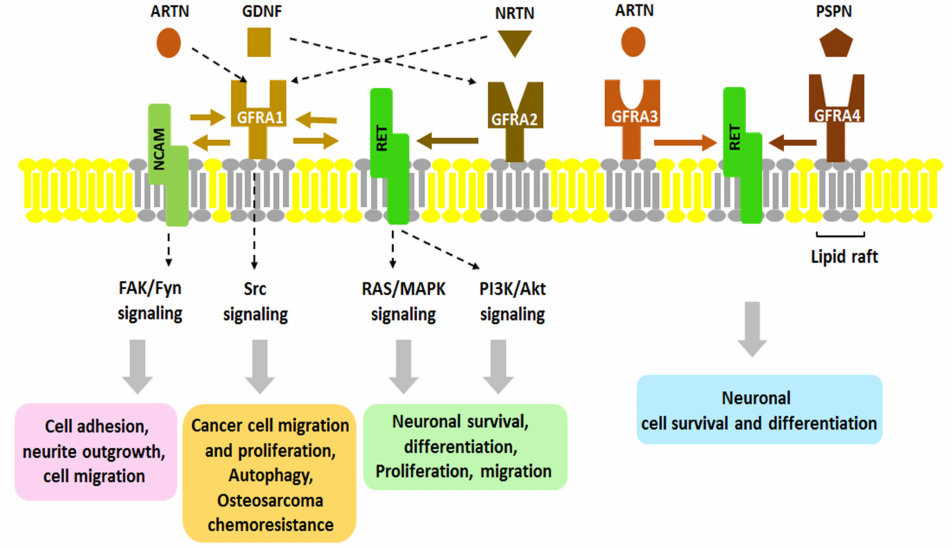
Figure 1. The interaction of glial cell line-derived neurotrophic factor (GDNF) family ligands (GFLs) with their receptors. Four homodimeric GFLs (GDNF, NRTN, ARTN, and PSPN) recognize their corresponding GDNF family receptor α (GFR α /GFRA1-4). GDNF specifically binds to GFRA1, NRTN to GFRA2, ARTN to GFRA3, and PSPN to GFRA4. Dotted arrow indicates cross-interaction of GFLs with GFRA which has been observed. Binding of GFL with GFRA activates protein tyrosine kinase RET. Neural cell adhesion molecule (NCAM) has been identified as an alternative signaling receptor for GFLs. RET also has been known as the representative receptor tyrosine kinases (RTKs) for these neurotrophic factor receptors. Activation of RET or NCAM via the GFL/GFRA complex is involved in various physiological functions, such as neuronal cell growth, differentiation, migration, and osteosarcoma chemoresistance via autophagy. Gray-colored area of the membrane indicates lipid raft. NRTN, neurturin; ARTN, artemin; PSPN,